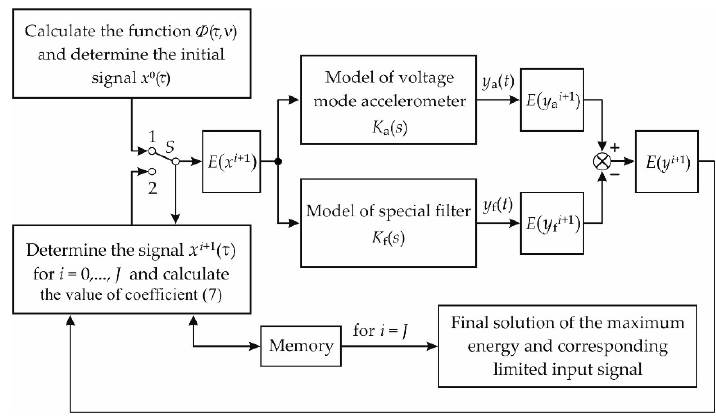
Figure 2. Block diagram of algorithm intended for determining the maximum energy (ME).